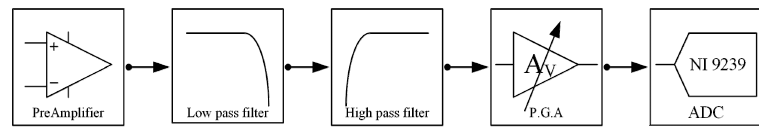
Figure 8. The receiving system structure.